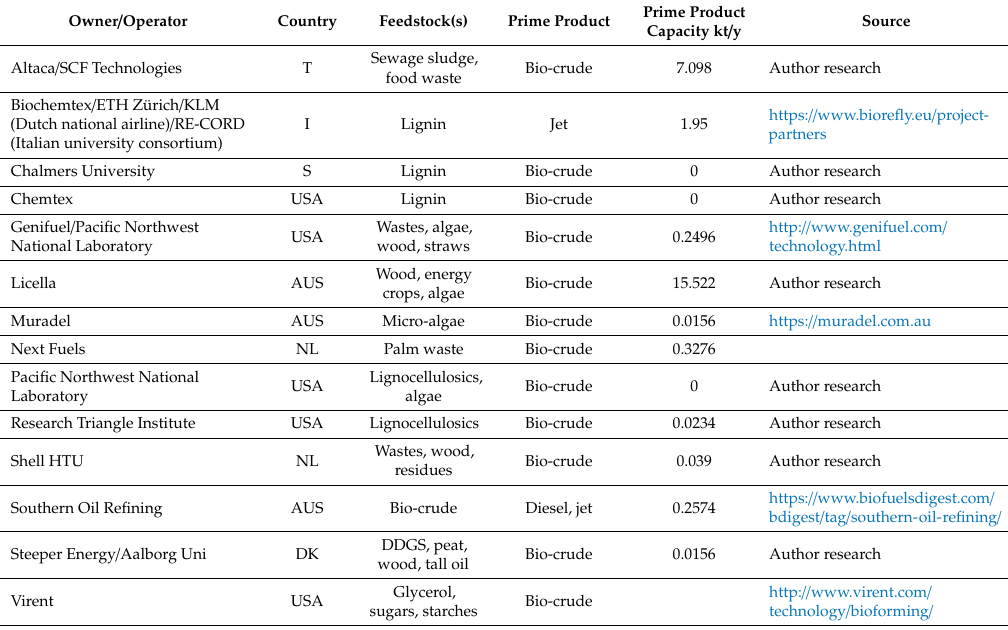
Table 11. Liquid conversion and synthesis projects for BioLPG, by owner /